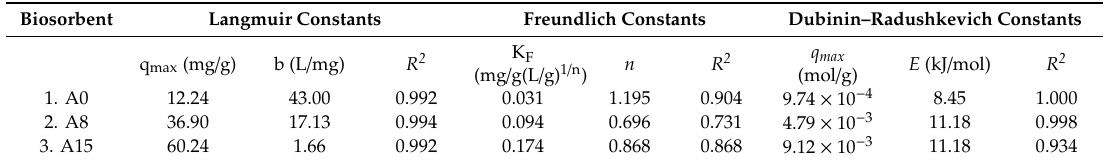
Table 3. Parameters of three linearized isotherm models regarding the three types of Aphanothece sp. biosorbents on batch sorption experiments (T = 30 ◦ C, t contacts = 60 min, pH = 8, biosorbent concentration of 0.1 g / L, and C 0 = 2.62–6.23 mg /